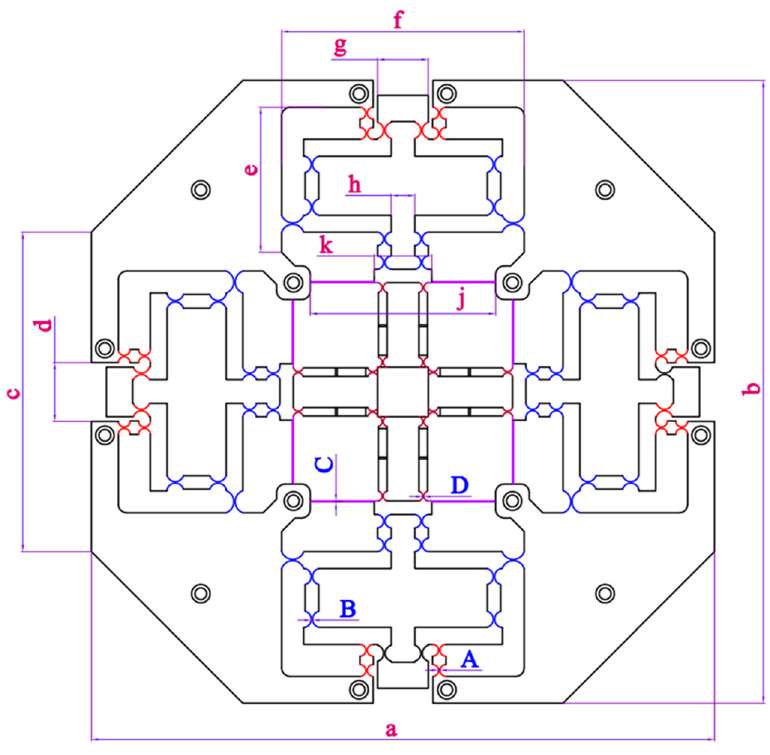
Figure 4. Basic parameters of XYZ micropositioner.